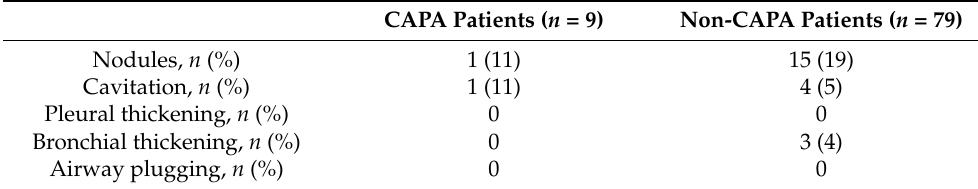
Table 6. Observed radiological features in CAPA and non-CAPA